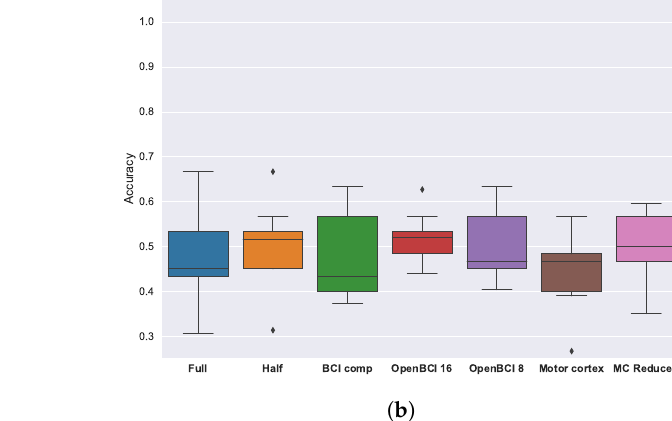
Figure 7. Cross-validation accuracies for different sensor subsets for the participant with the best mean accuracy (P12) ( a ) and lowest accuracy (P02) ( b ), respectively, when using the full sensor